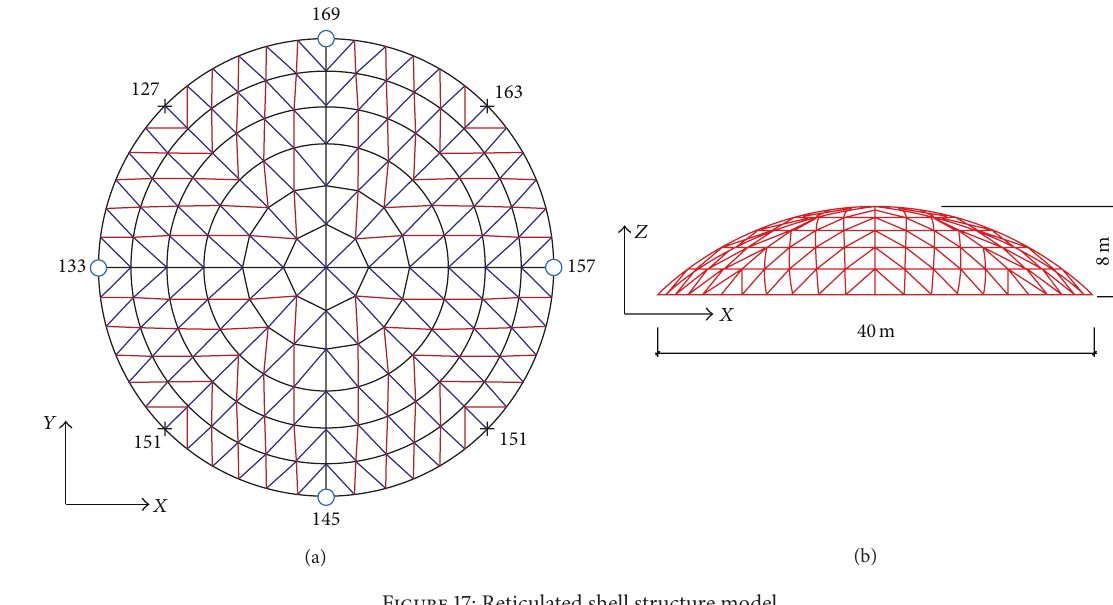
Figure 17: Reticulated shell structure model.